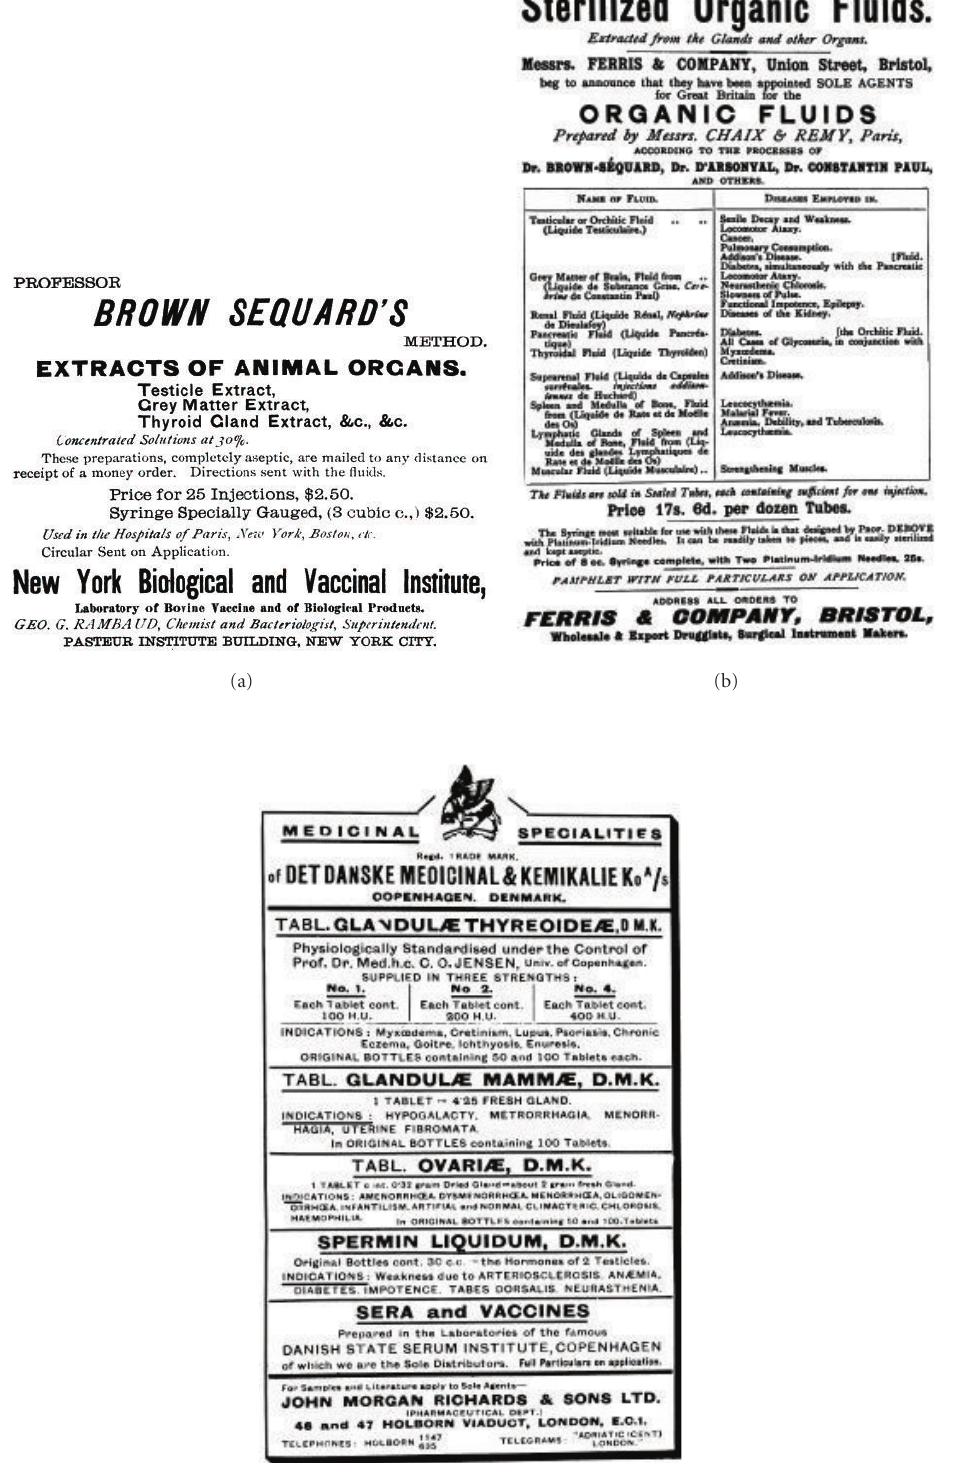
Figure 3: Advertisements for organotherapeutical